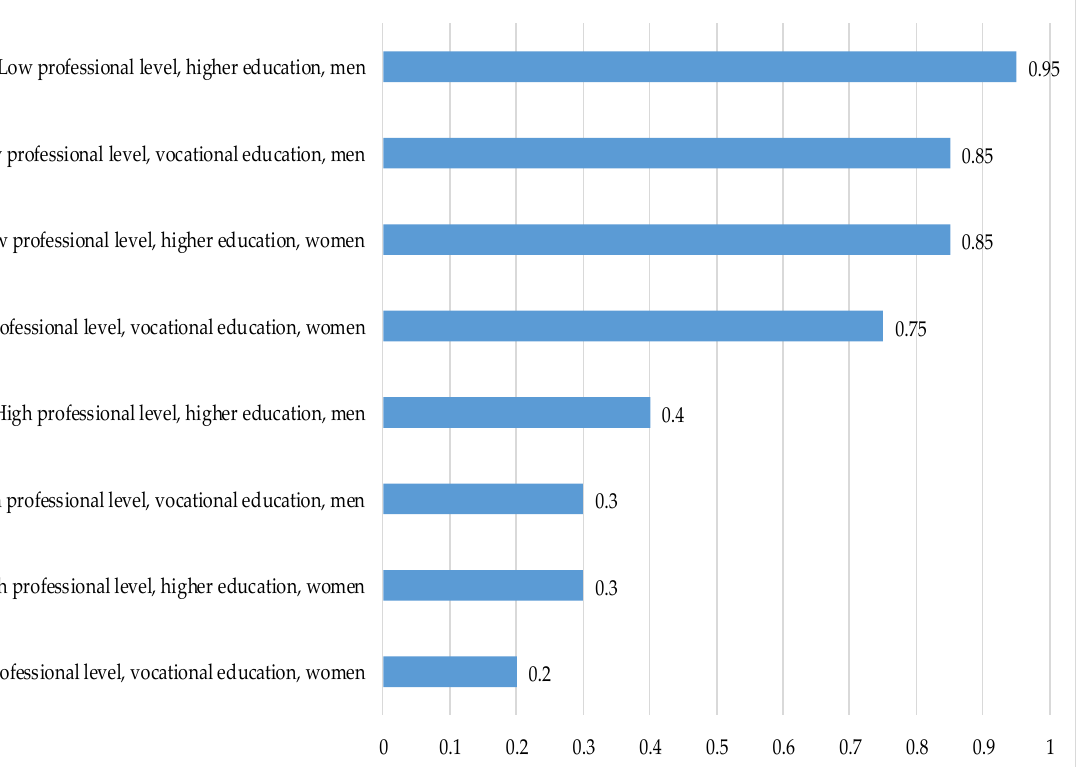
Figure 1. Probability of not working in the specialty by population group (author’s research).